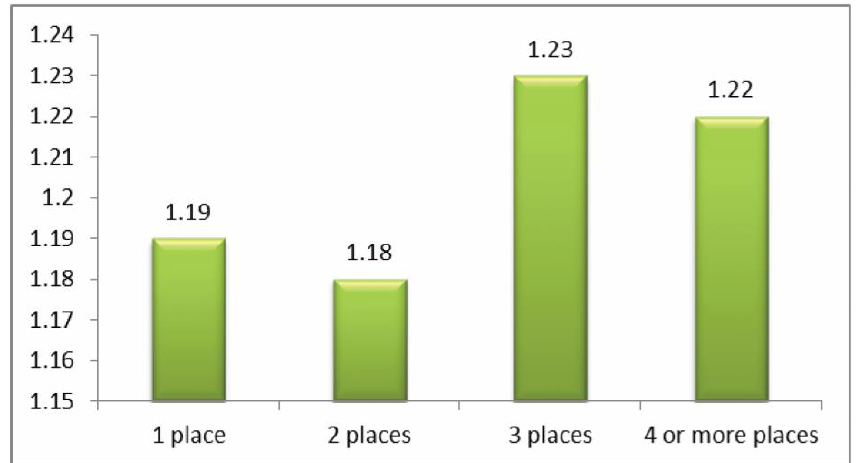
Figure 3. The risk of being a cybervictim (4-point scale), by numbers of sites used for internet access for the adolescents who used the internet ( n = 1140).